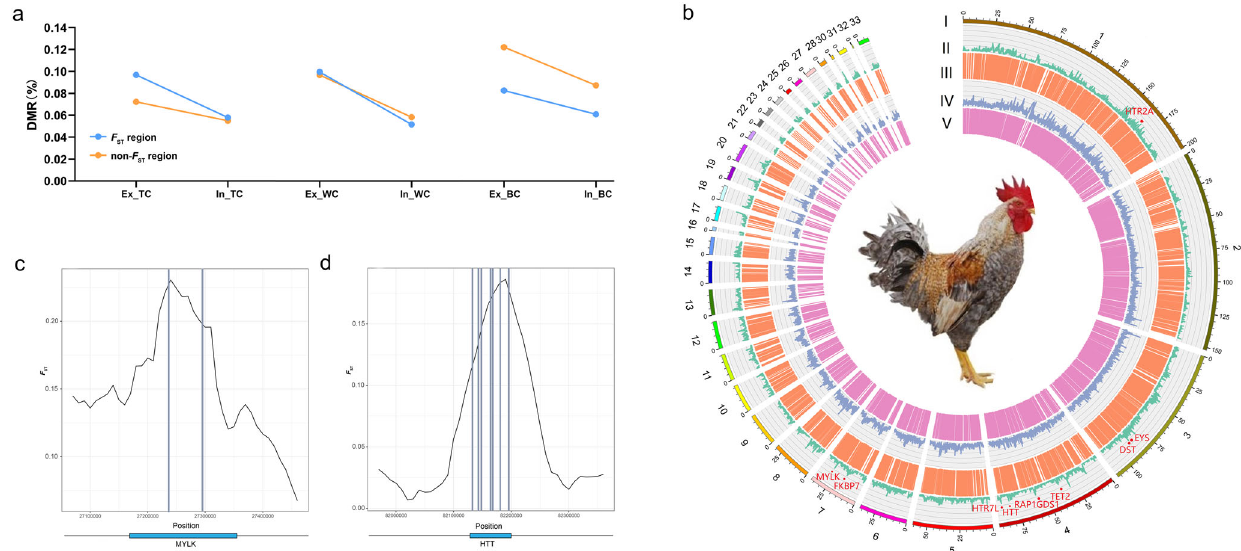
Fig. 5 DNA methylation variations contribute to genomic selection signatures (s-DMRs) during Ex conservation programme of TC. a Percentage of DMRs in F ST selection regions and other regions of indigenous chicken breeds (TC: Tibetan chicken, WC: Wenchang chicken and BC: Bian chicken) during different conservation programmes (In – in situ conservation and Ex – ex situ in vivo conservation). b Genome and methylation landscapes during different conservation programmes of TC. From outer to inner circles are as follows: chromosome scheme (I), selective sweeps detected during Ex programme (II), DMRs during Ex programme (III), selective sweeps detected during In programme (IV), and DMRs during In programme (V). Red dots in circle II denote genes located in s-DMRs. c , d Two prominent genes MYLK ( c ) and HTT ( d ), which were located in s-DMRs during Ex programme of Tibetan chickens. Grey shadow depicts the location of